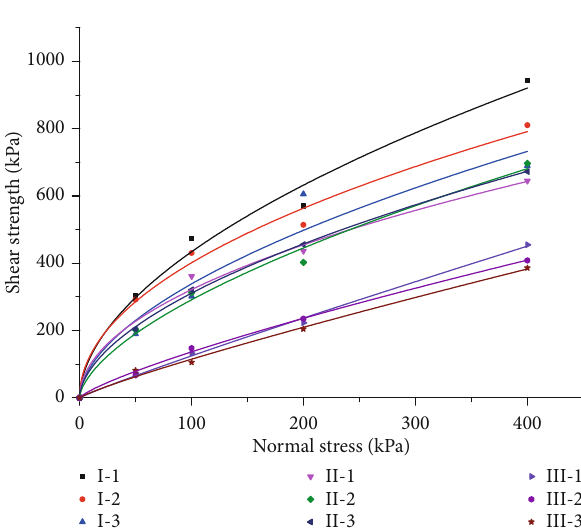
Figure 5: Relationship between stress ratio and d 50.